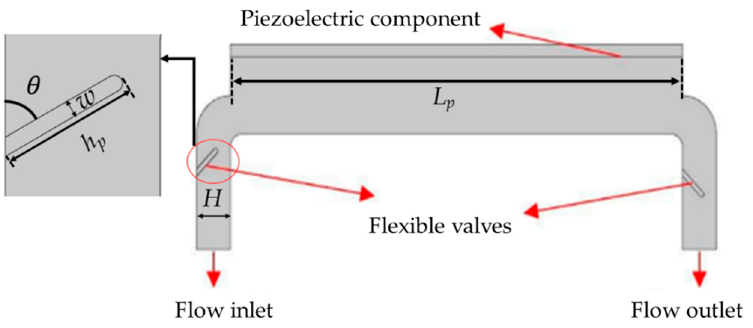
Figure 2. Domain of the piezoelectric pump.